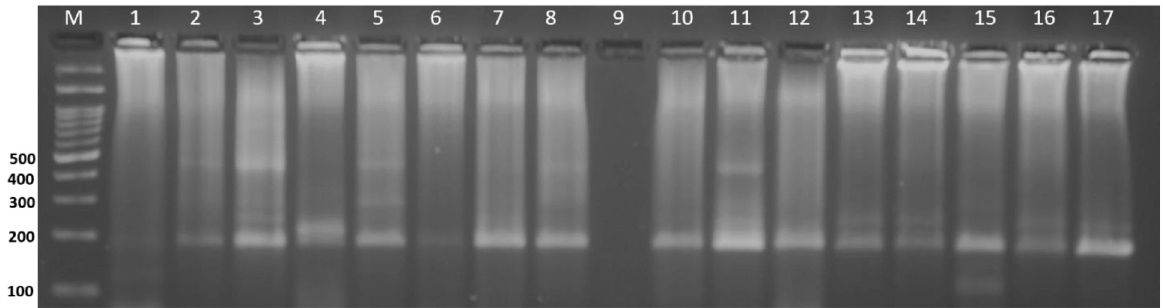
Fig 3. Representative nested Cp-PCR amplification products from the second PCR reaction. Positive samples show amplified products of 183 bp in lanes 1–8 and 10–16, lane 9: negative control, lane 17: positive control, and lane M: 100 bp DNA ladder.